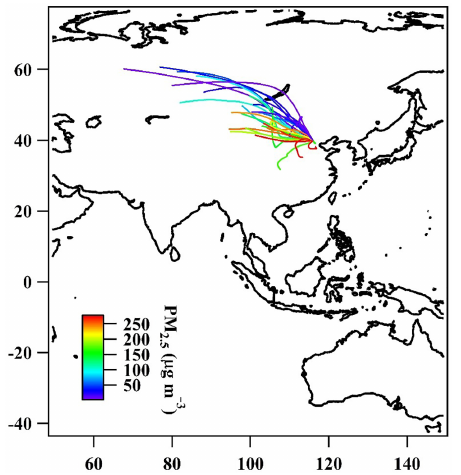
Figure 2. The 2-day back-trajectories obtained by the NOAA HYS- PLIT model color-coded with respect to PM 2 . 5 mass concentration determined by PTFE filters.